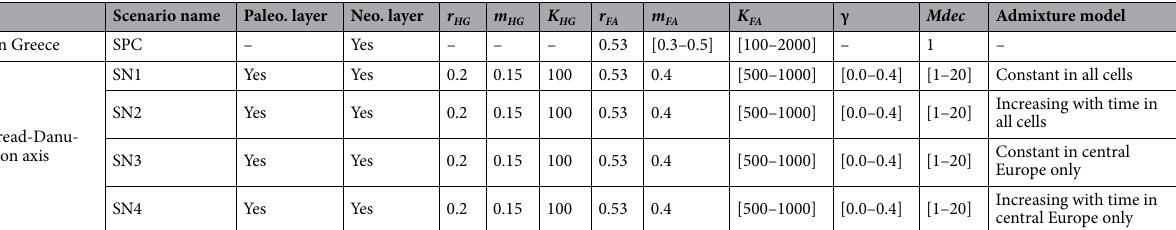
Table 1. Input parameter for SPLATCHE2 for the various scenarios simulated. SPC corresponds to the parameter used for Structured Population Continuity test and SN1 to SN4 represent the four alternative scenarios of the Neolithic spread along the Danubian expansion axis. The parameters of interest were drawn from prior distributions to make inferences by estimating their posterior distributions using the ABC (see text). HG stands for the hunter-gatherers population layer and FA for the farmer population layer; r HG and r FA stand for the growth rate in hunter-gatherers and farmers, respectively; m HG and m FA for the migration rates; K HG and K FA for the carrying capacities; γ for the assimilation rate and Mdec for the factor of migration rate decrease in farmers when their carrying capacity reaches